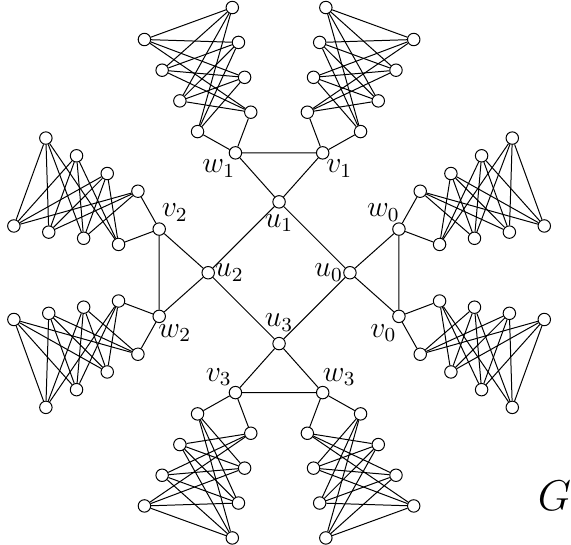
Figure 4: The graph G is a 4-regular, 2-edge-connected graph with proper connection 4 number greater than 2.